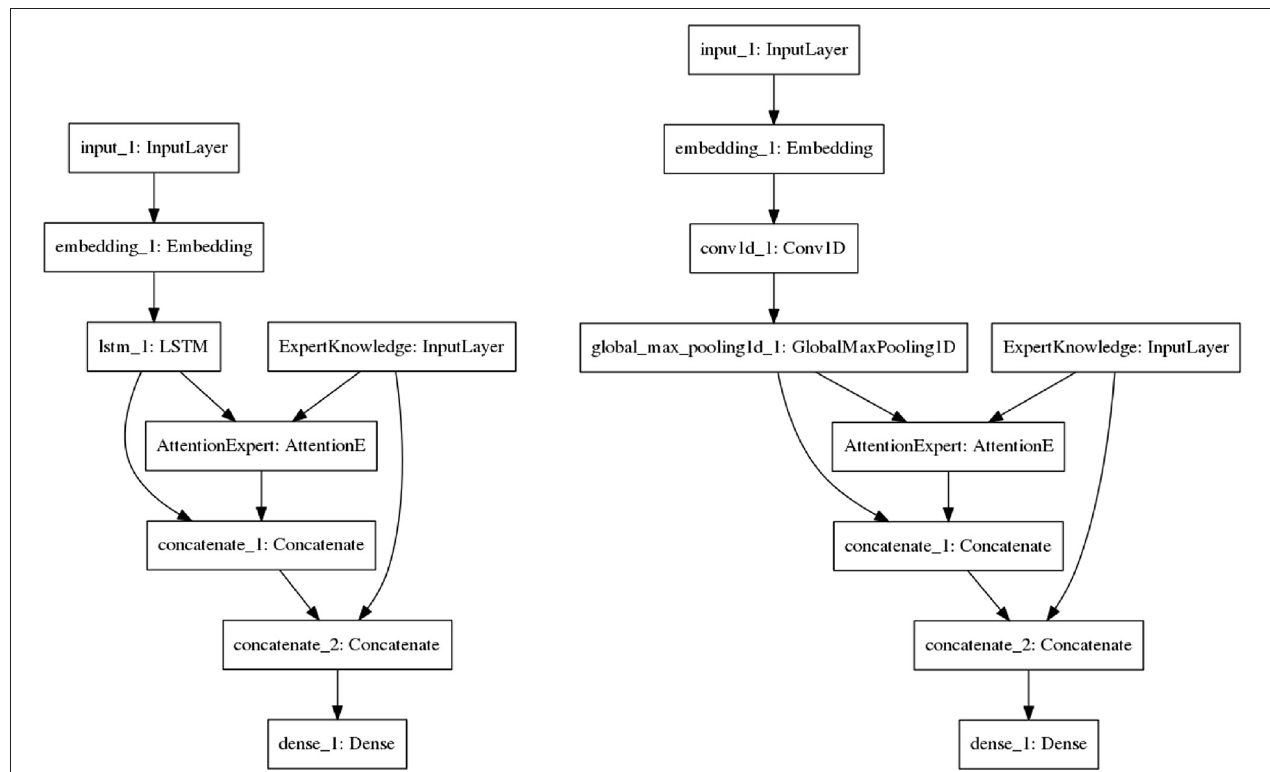
FIGURE 7 | The proposed hybrid architecture using LSTM (left) or CNN (right) for the prediction of socio-moral reasoning level.